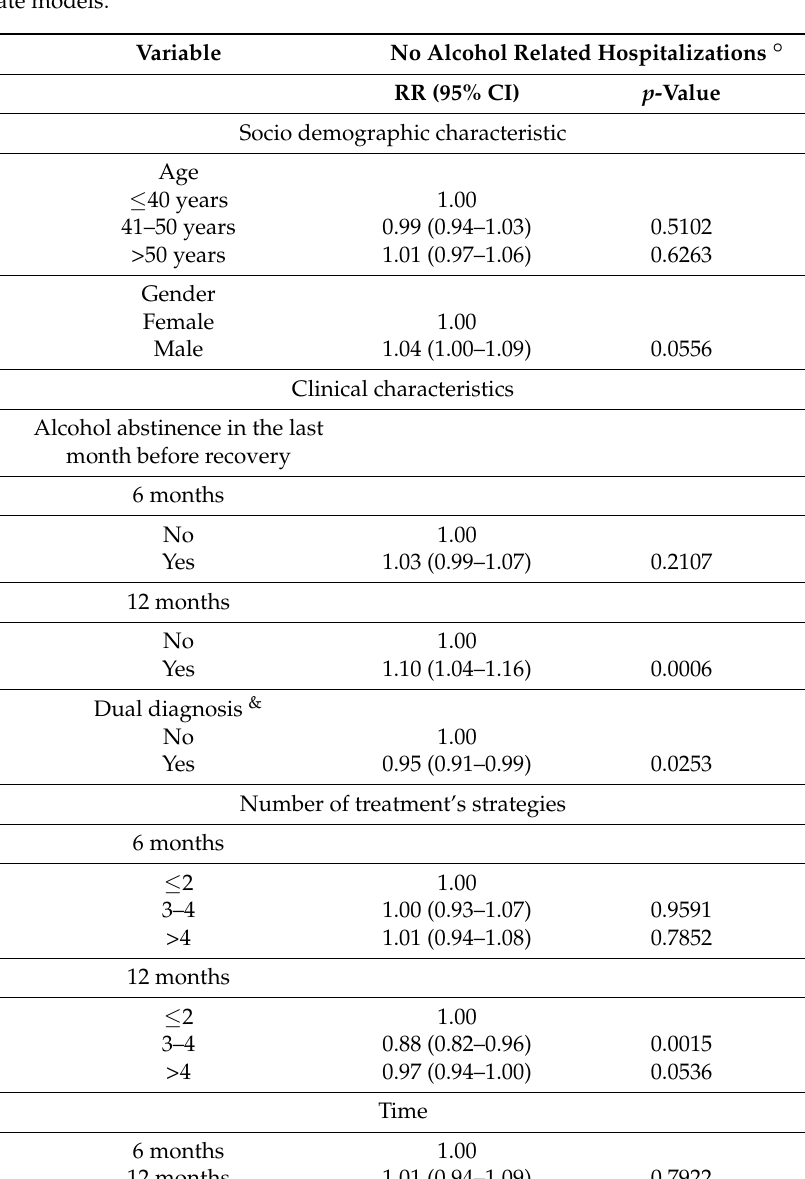
Table 4. Association between sociodemographic and clinical characteristics, and the number of treatment strategies and no alcohol related hospitalization at 6 and 12 months, using multivariate